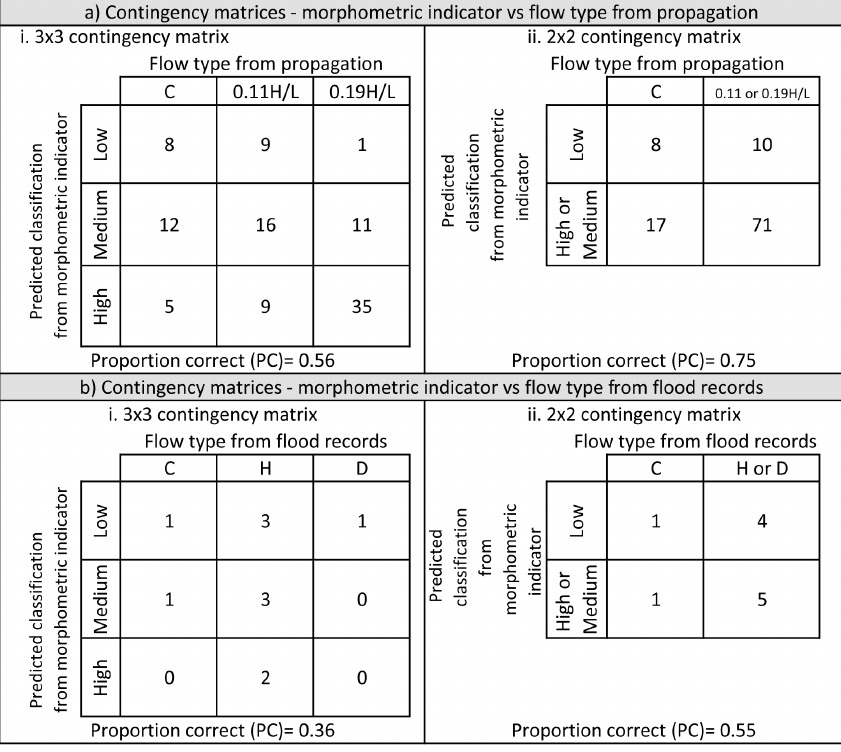
while the 2 × 2 contingency table provides a proportion cor- rect of